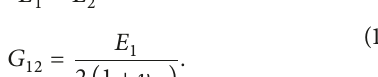
Figure 4: Modal test for thick glass/epoxy plates